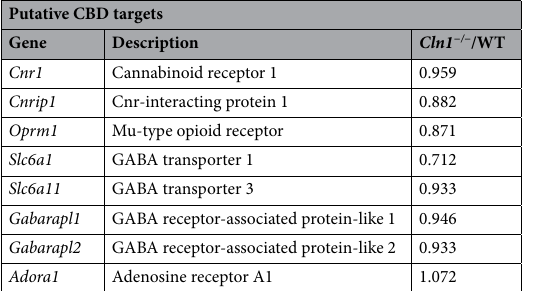
Table 1. Proteomic analysis revealed that many putative CBD targets remain intact in Cln1 −/− mice despite widespread neurodegeneration at 7 months of age.